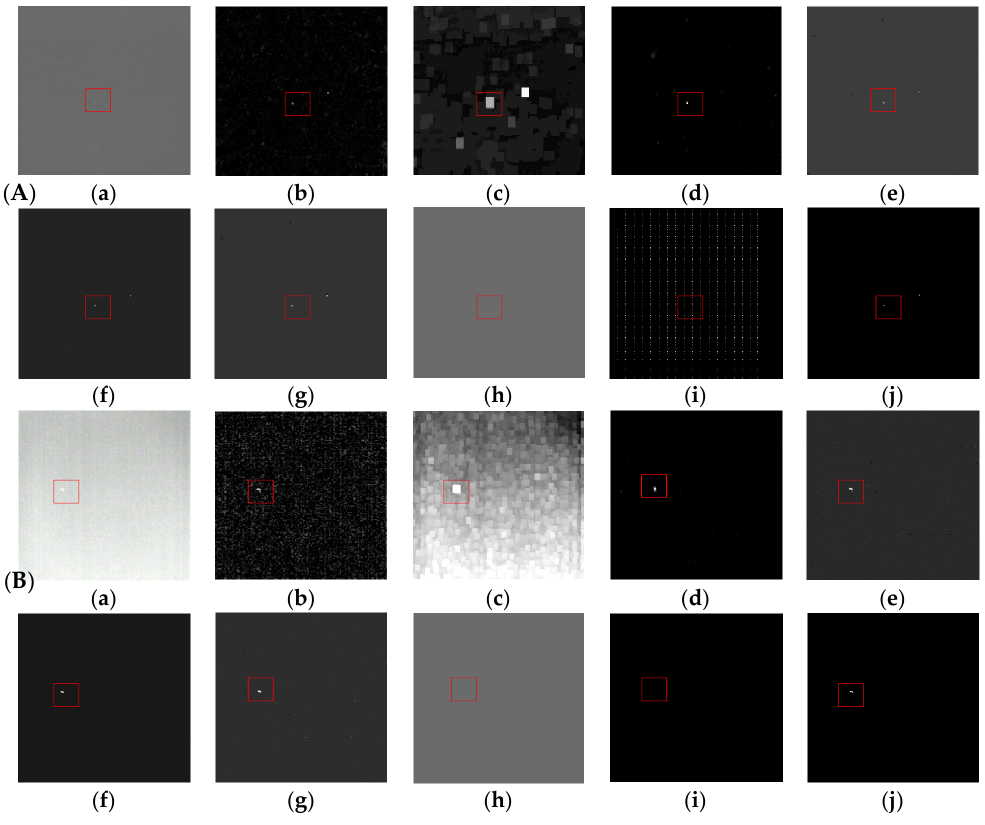
Figure 7. Results of the different approaches to Scenes 1 and 2. ( A ) Scene 1 (Sequence 1); ( B ) Scene 2 (Sequence 2); ( a ) Original image; ( b ) Tophat; ( c ) LCM; ( d ) MPCM; ( e ) IPI; ( f ) NIPPS; ( g ) ReWIPI; ( h ) SMSL; ( i ) RIPT; ( j )